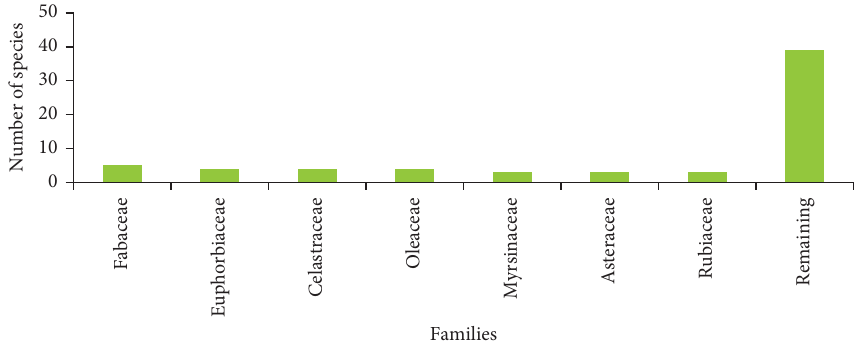
Figure 4: Number of species with the distribution of families. Table 1: Six plant species identifed were not registered in Gonder foristic region of Ethiopia. Species name